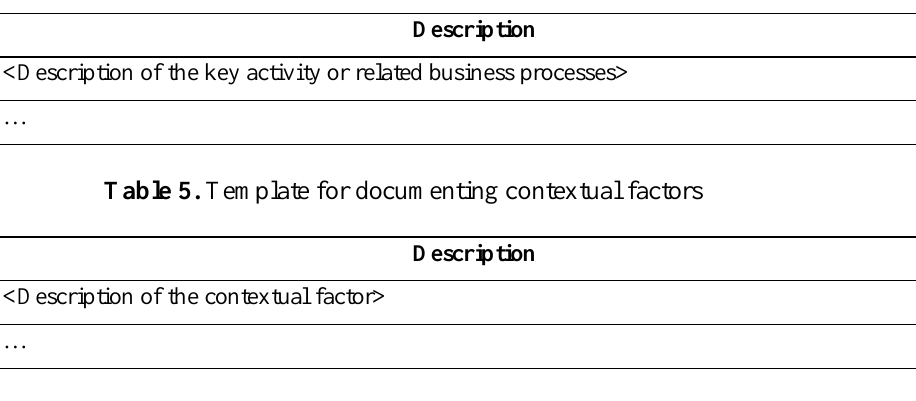
Table 4. Template for documenting key activities